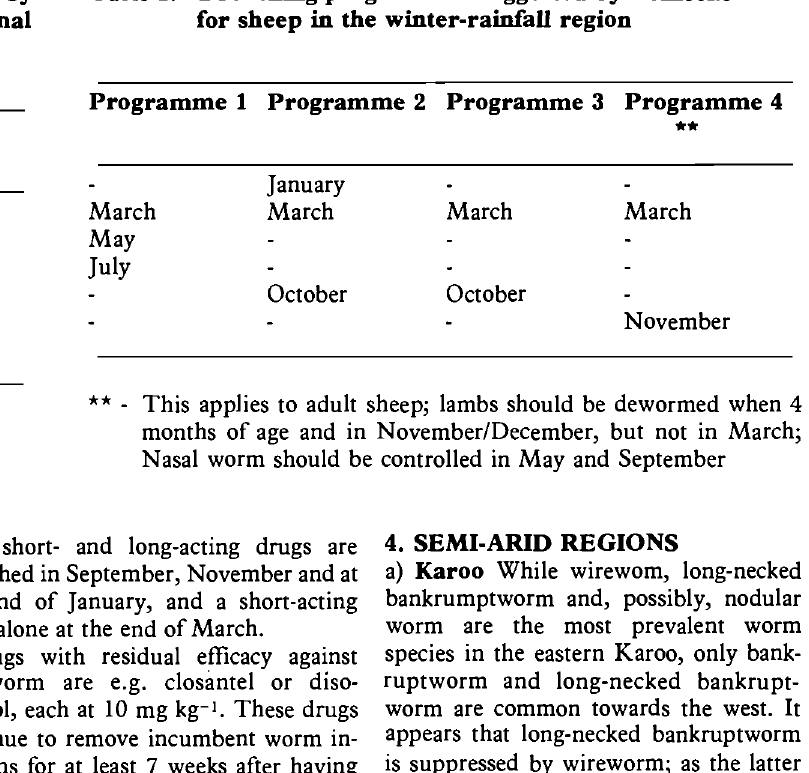
Table 1 Drenching programmes. suggested by Table 2: Drenching programmes suggested by Reinecke 19 20 21 for sheep in the winter-rainfall region